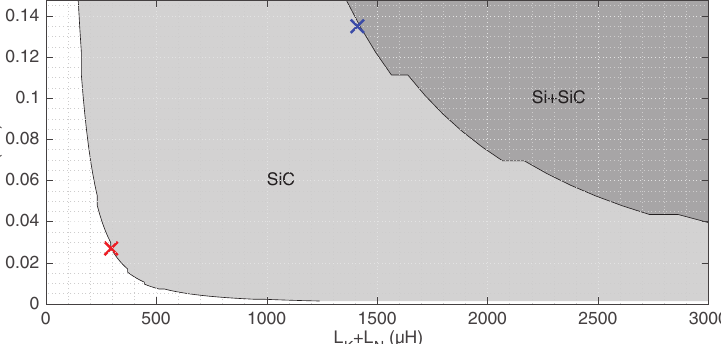
Figure 12. Areas of possible filter solutions for SiC and Si, red cross marks the selected filter design for SiC and blue cross for